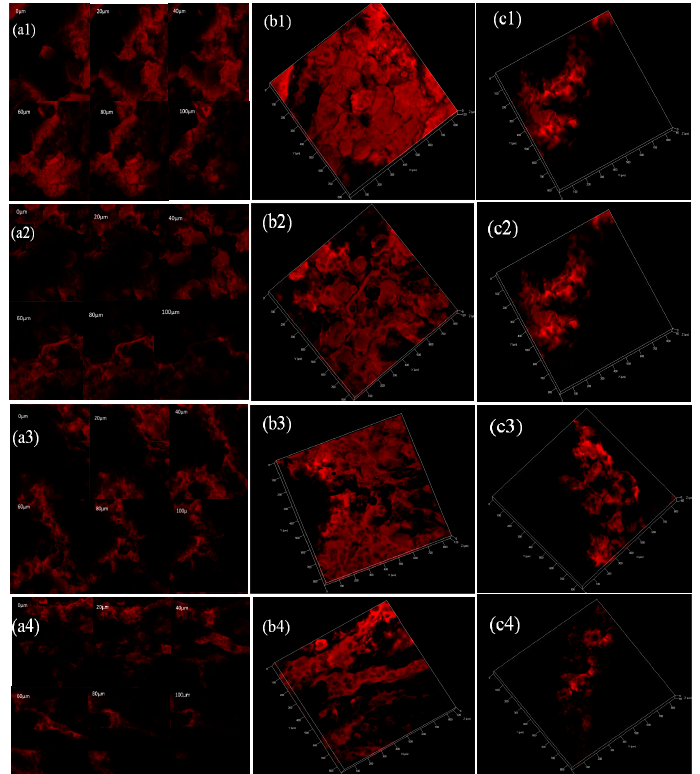
Figure 3. Fluorescence mode confocal laser scanning microscopy (CLSM) images of oil distribution in control (1), guar gum coated (2), blanching with calcium ion and guar gum coated (3), plasticized guar gum coating with sorbitol (4) of French fries. ( a ) Gallery of CLSM images at different depths; ( b , c ) 3D reconstructions of CLSM galleries; ( b ), the surface of contact with oil; ( c ), opposite to the surface of contact with oil. Each image in the gallery and the 3D image: 1024 × 1024 μ m.